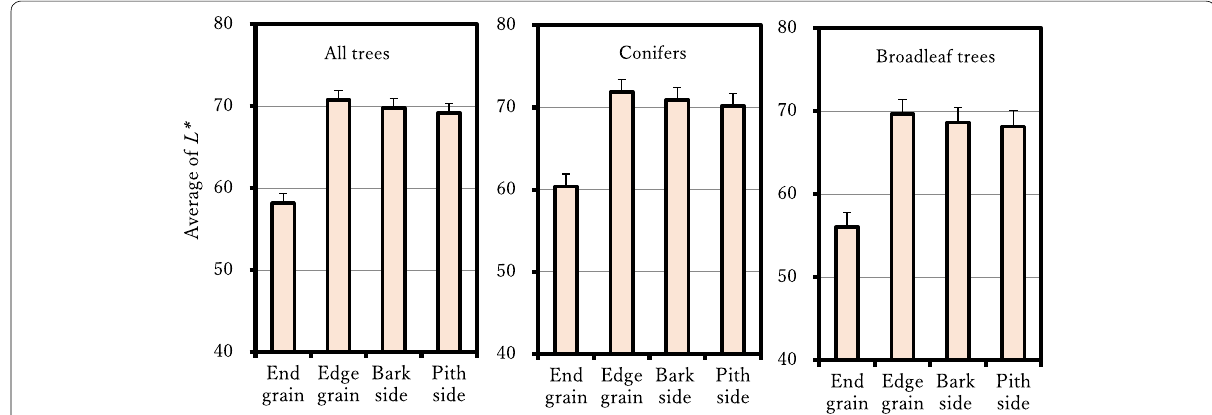
Fig. 4 Lightness L* of measured planes of test pieces. Only standard errors for the plus side are shown at the end of each